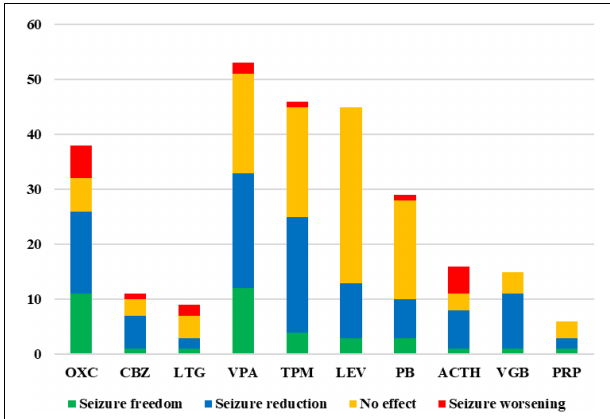
FIGURE 4 | Treatment effects of anti-seizure medication (ASM) therapies in epilepsy patients with SCN2A variants. Number of treated patients and their seizure outcome (green = seizure freedom; blue = seizure reduction; orange = no effect; red = seizure worsening) that have been treated with different ASM therapies. Only effects of ASM therapies that at least one patient achieved seizure free are shown. OXC, oxcarbazepine; CBZ, carbamazepine; LTG, lamotrigine; VPA, valproate; TPM, topiramate; LEV, levetiracetam; PB, phenobarbital; VGB, vigabatrin; PRP,